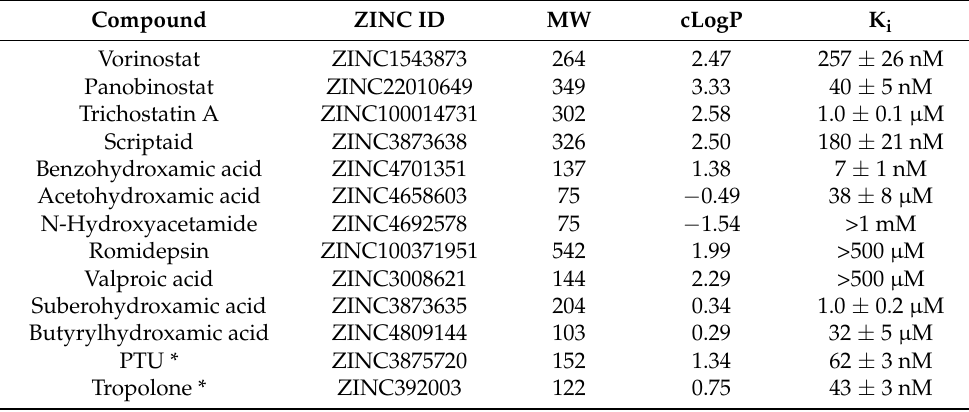
Figure 1. Tested molecules. Of the 13 molecules, phenylthiourea and tropolone are positive controls. Table 1. Molecules and their inhibition for mushroom tyrosinase.